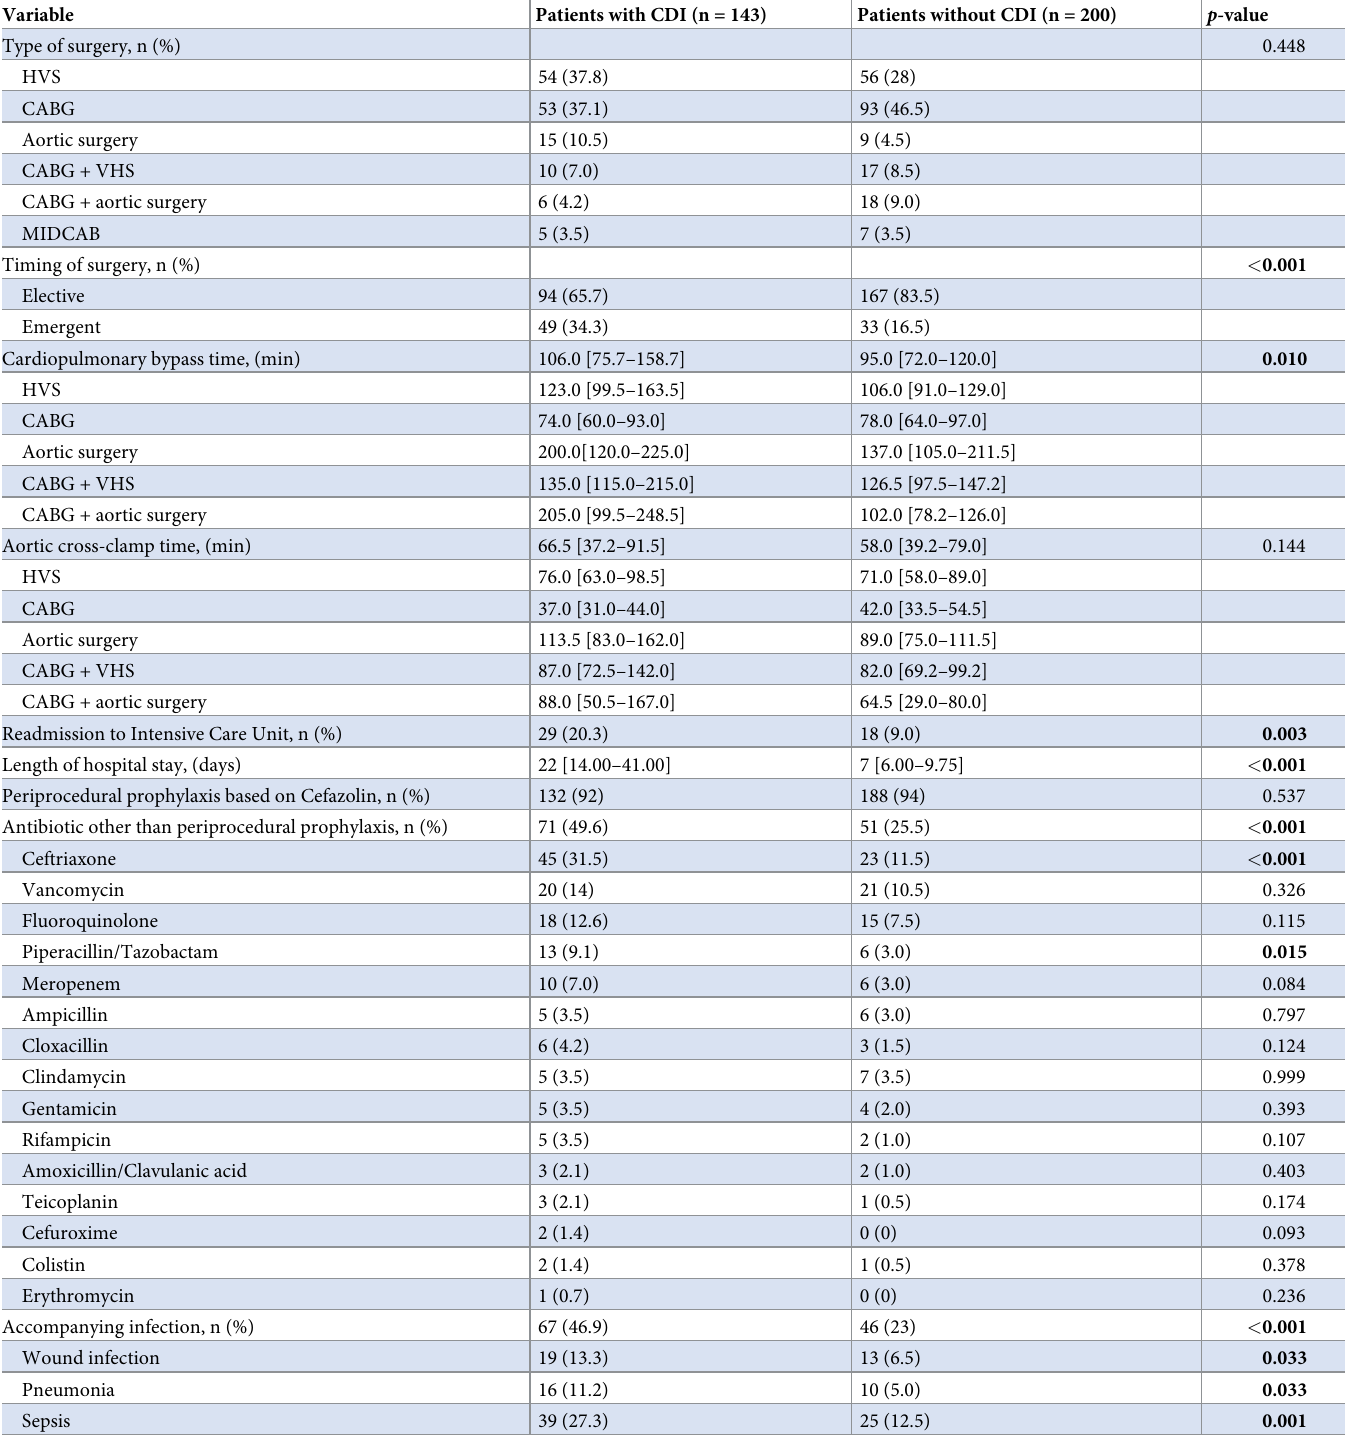
Table 3. Perioperative